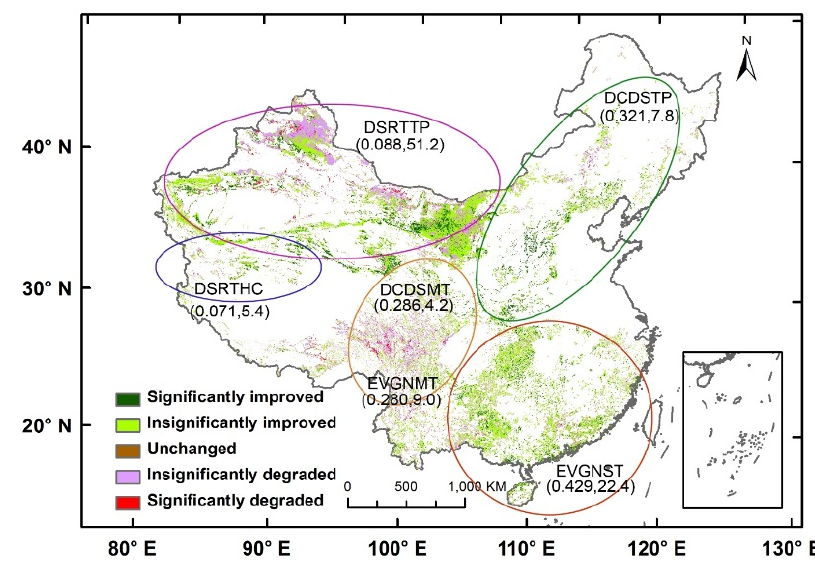
Figure 1. Pixel-based nonparametric trend analysis from 2001 to 2013. The circles indicate the distribution of different shrubland types. The first number in bracket indicates averaged EVI during the 13 years, and the second number indicates the percentage of total shrubland area. DCDSMT and EVGNMT are in one circle because there is no clear boundary between them. DCDSMT mainly distributed in the upper half of the circle and EVGNMT distributed in the bottom half. Table 1. Pixel-based nonparametric trend analysis. TS stands for Theil–Sen median slope estimator. TS Z (Mann–Kendall) EVI Trend Class Area (%) >0 >1.96 Significantly